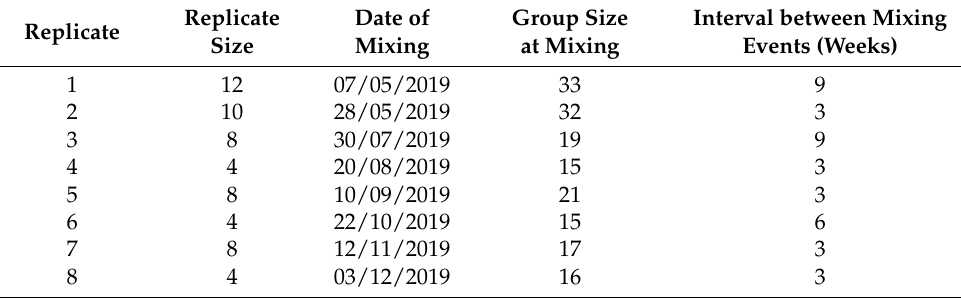
Table 1. Details of experimental schedule and